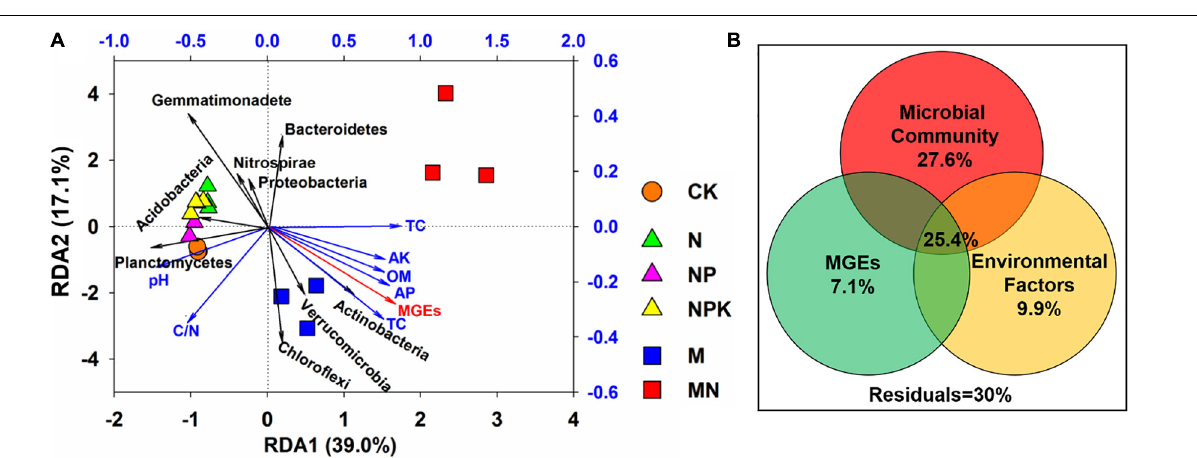
FIGURE 7 | (A) Redundancy analysis (RDA) revealing correlations among ARGs, main phyla taxa ( > 1% in any sample) and soil properties. (B) Variation partitioning analysis (VPA) interpreting the effects of microbial community, soil properties and MGEs on the variations in ARGs. The absolute abundance of ARGs and MGEs was log10-transformed. The structure of the microbial community was represented using PCo1 and PCo2 from the PCoA based on Bray-Curtis